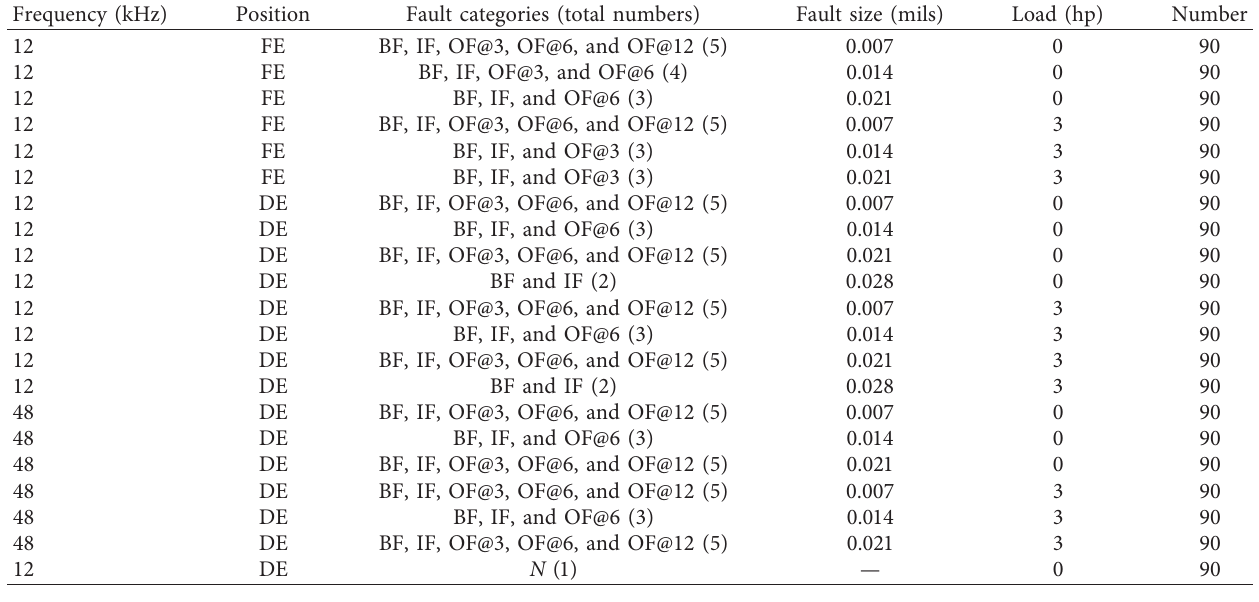
Table 3: Description of the training datasets.